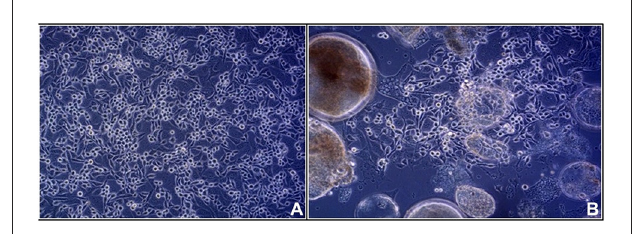
FIGURE1 Viper heart (VH2) cell line: (A) control (B) syncytium formation induced by infection with KP3 reptilian orthoreovirus strain.